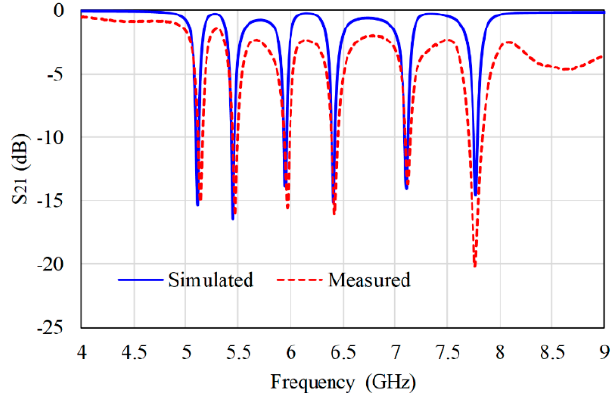
Figure 11. Measured and simulated S 21 for code (111111111111).